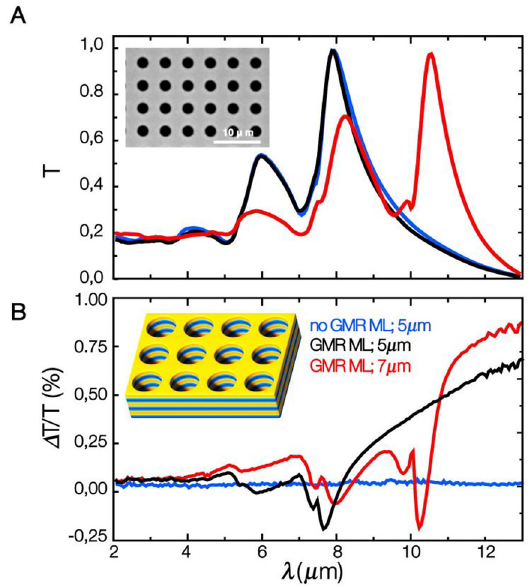
Figure 10: MRE mediated magnetic modulation of propagating plasmons in the mid IR. (A) Normalized transmission spectra at normal incidence for unpolarized light for membranes fabricated on Ni 81 Fe 19 /Au multilayers without GMR (blue line 5 μ m period) or with GMR (black line 3.8% GMR and 5 μ m period, red line 4.2% GMR and 7 μ m period). The spectra show the characteristic Extraordinary Optical transmission (EOT) peaks, linked to the excitation of propagative plasmons. The inset shows an SEM image of a membrane fabricated on a Ni 81 Fe 19 /Au multilayer. (B) MRE spectra ( Δ T/T=(T P -T AP )/T AP ) for the same membranes. The membrane fabricated on the multilayer without GMR shows no signal (blue line), whereas the membranes fabricated on the multilayers with GMR (black and red lines) show derivative like features at the position of the EOT peaks, due to the modulation of propagative plasmons, superimposed to a broad band originated from the multilayer. The inset shows a schema of the membrane with its internal